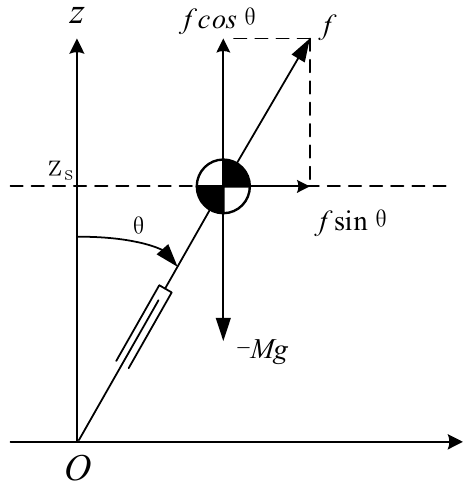
Figure 1. Linear inverted pendulum model-center of mass (LIPM-CoM) moving with constant height.